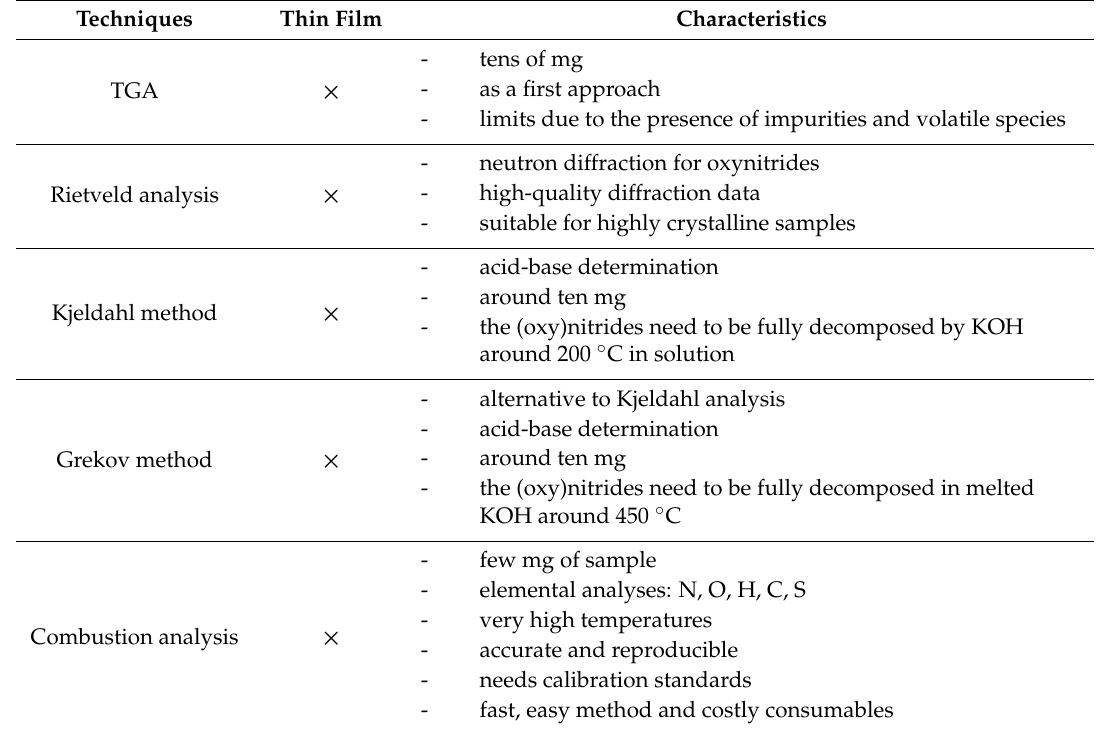
Table 1. Characteristics of the chemical